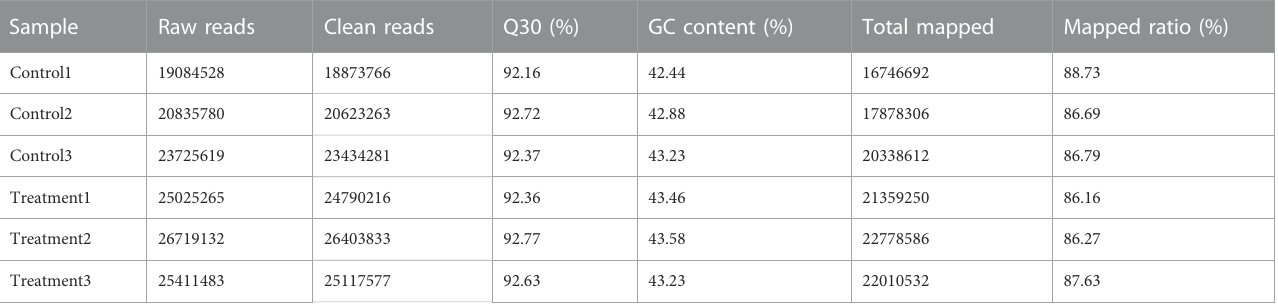
TABLE 1 Transcriptomic sequencing and assembly quality.